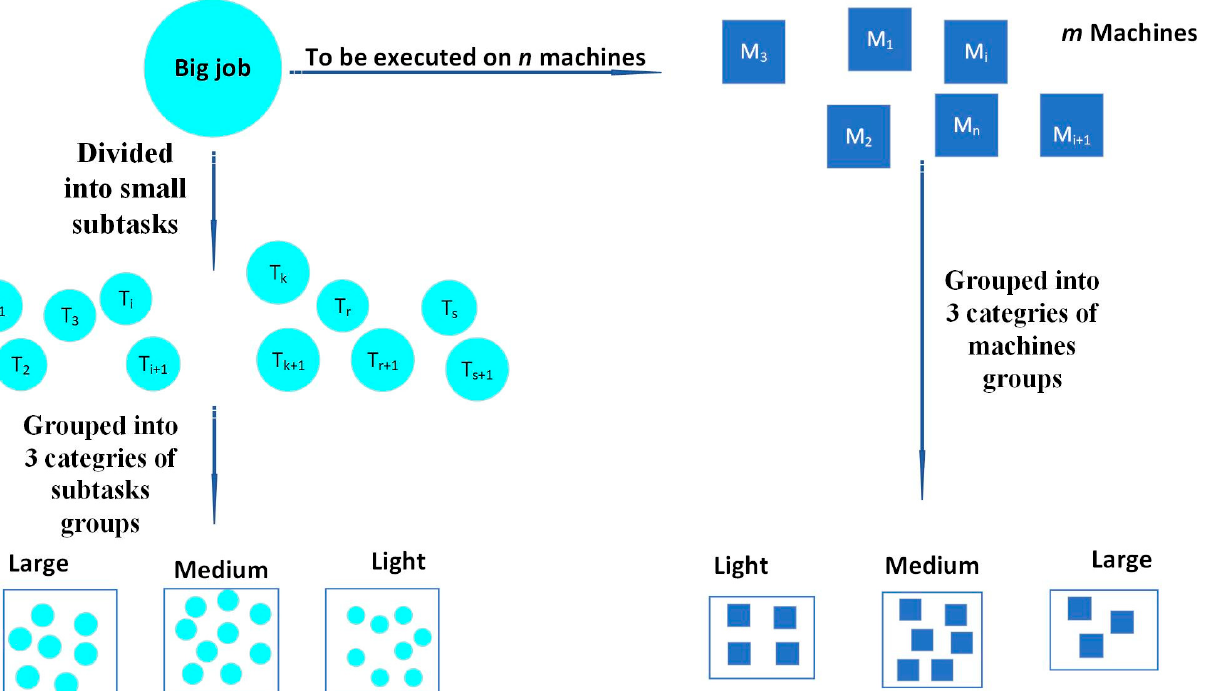
Table 6. The variables and their description.